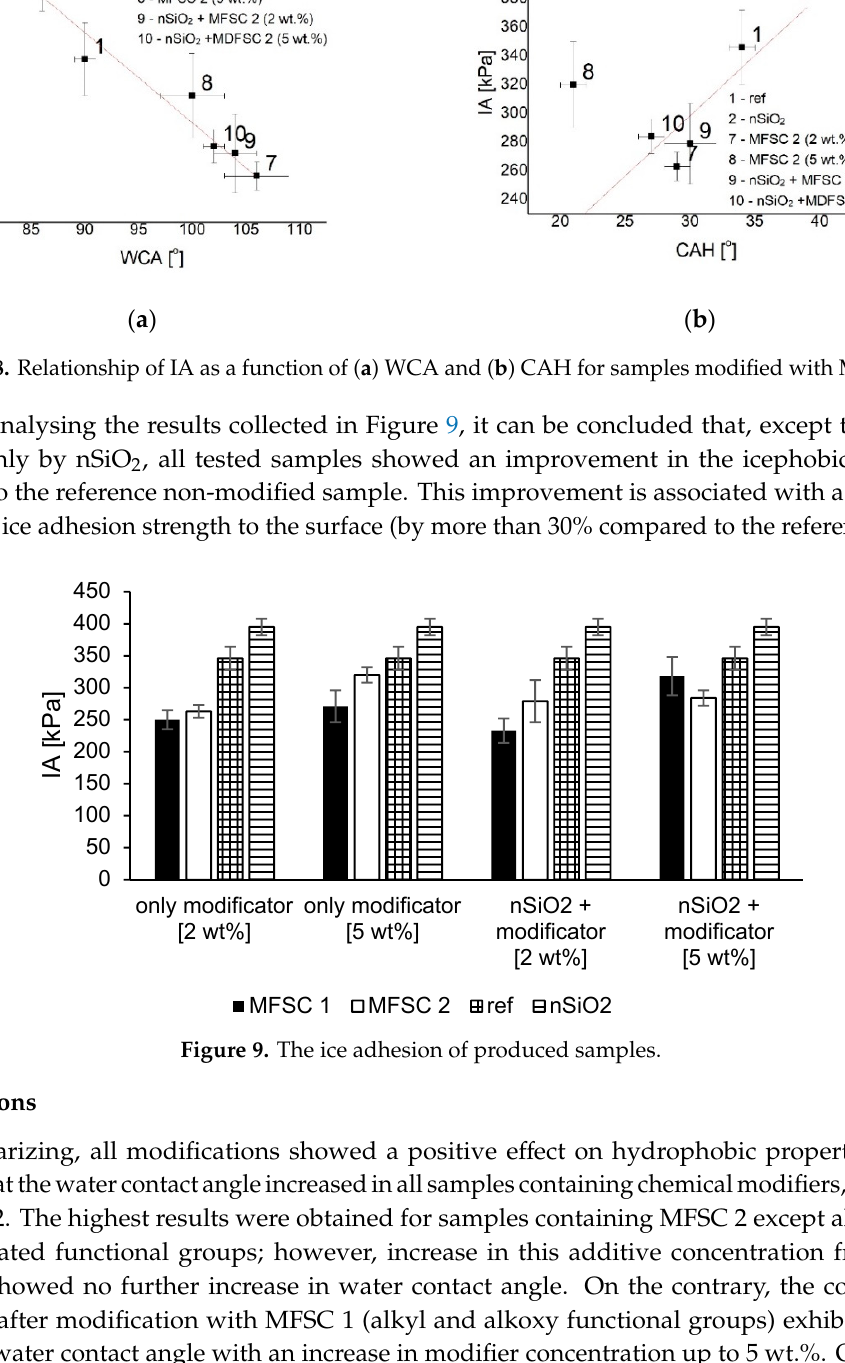
( b ) Figure 7. Relationship of IA as a function of ( a ) WCA and ( b ) CAH for samples modified with MFSC 1. Figure 8 shows the relationship between wettability parameters and ice adhesion for samples